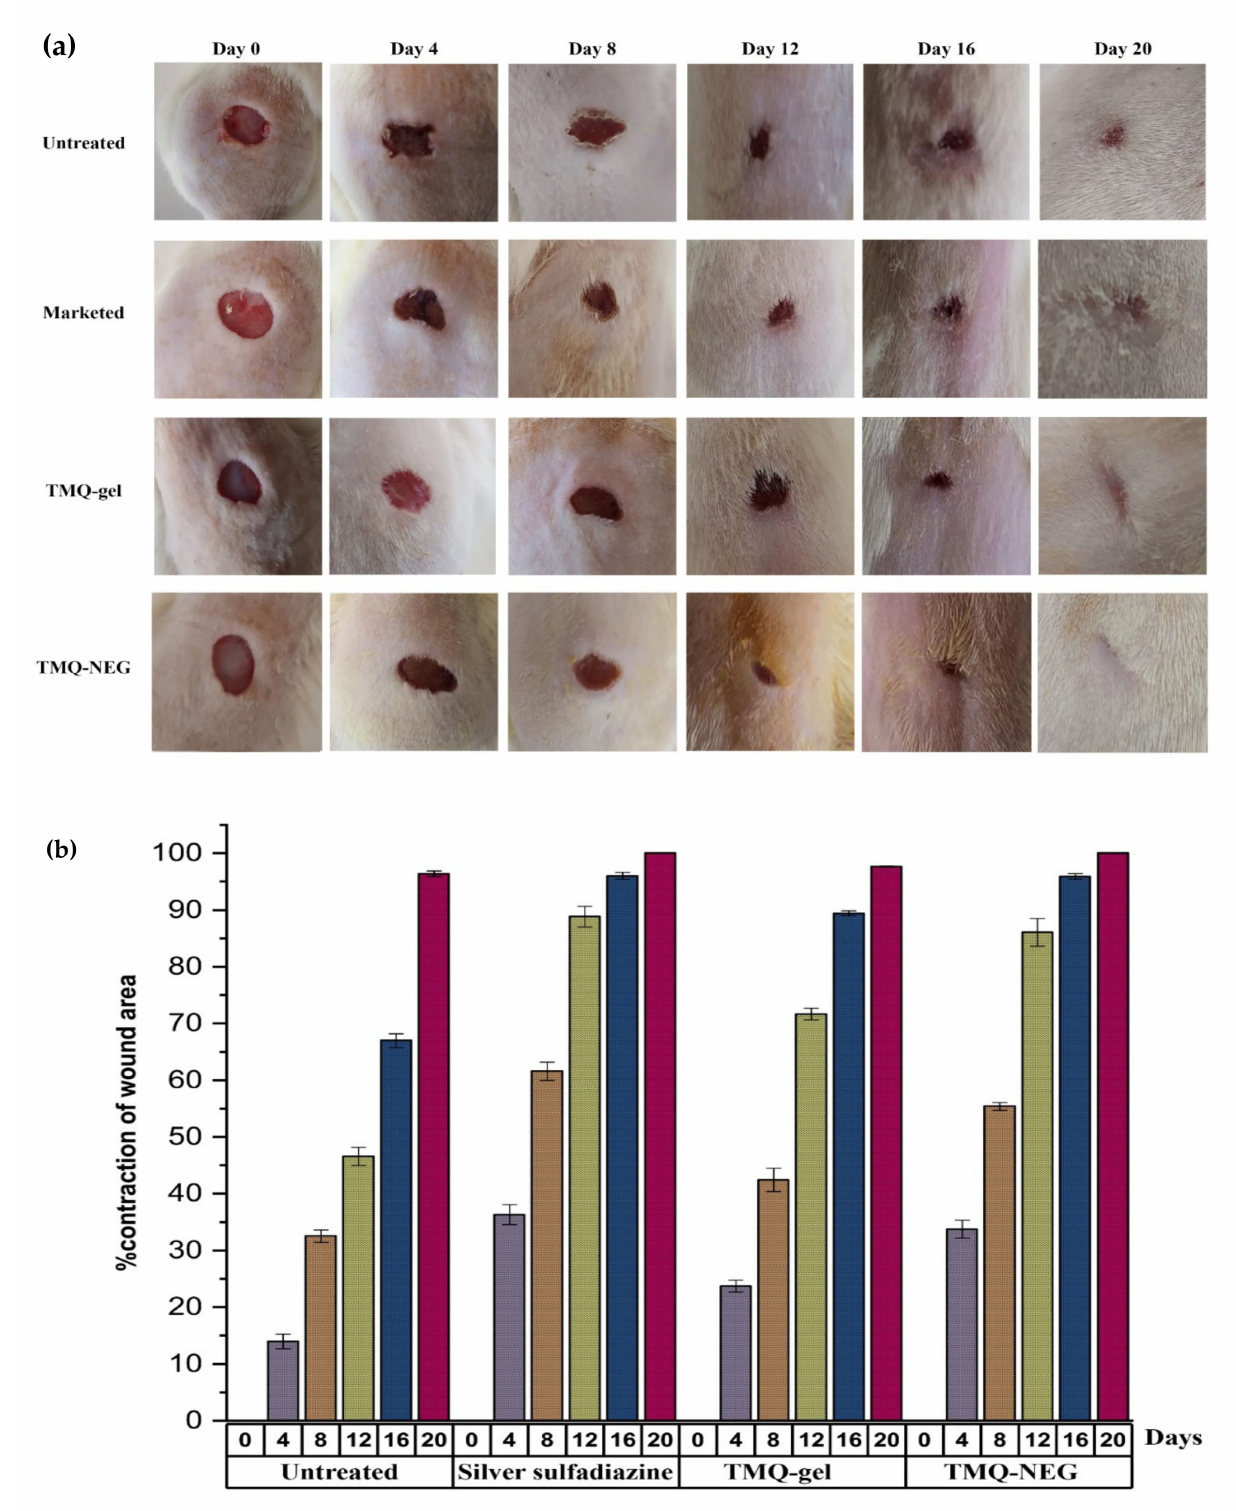
Figure 5. ( a ) In-vivo wound healing study in Wistar rat ( b ) percentage contraction of wound area as an evaluation parameter for in-vivo wound healing activity of marketed silver sulfadiazine cream, TMQ-gel, and TMQ-NEG in the Wistar